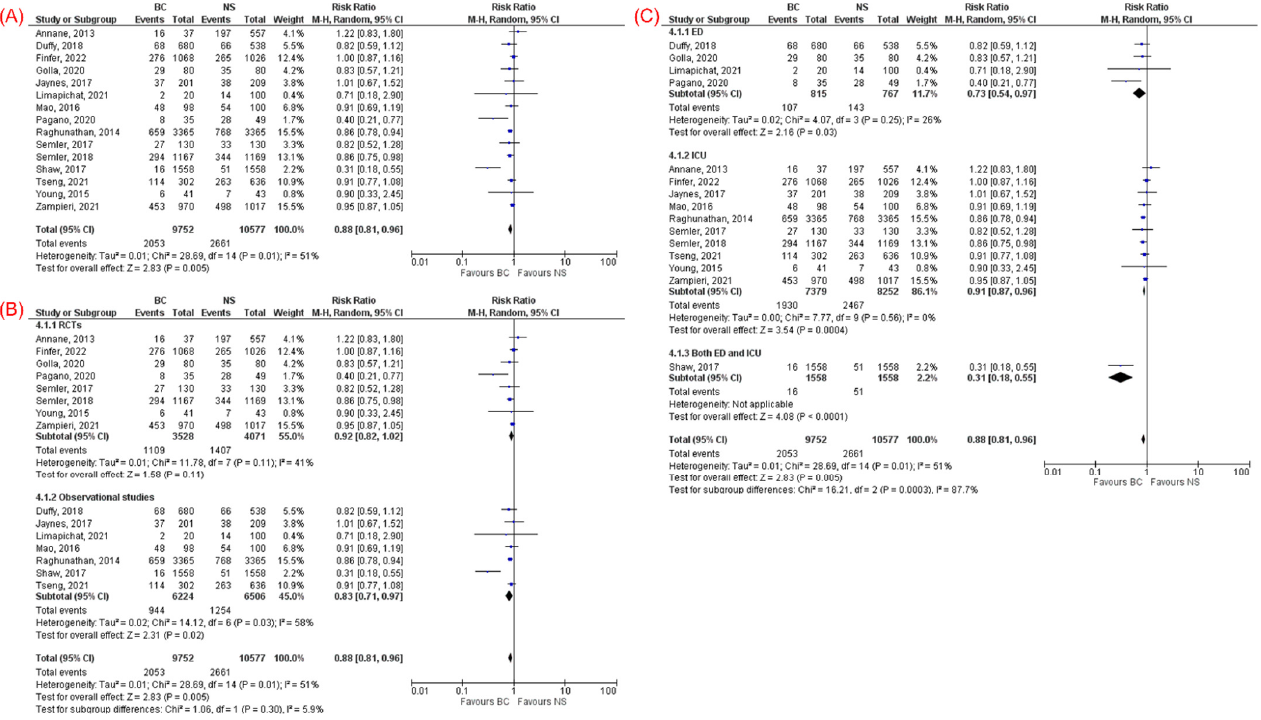
Figure 2. ( A ) Forest plot comparing balanced crystalloids and normal saline regarding overall mor- tality. ( B ) Subgroup analysis based on the study design (RCTs vs. observational studies) for overall mortality. ( C ) Subgroup analysis based on enrollment location (ED vs. ICU) for overall mortality.